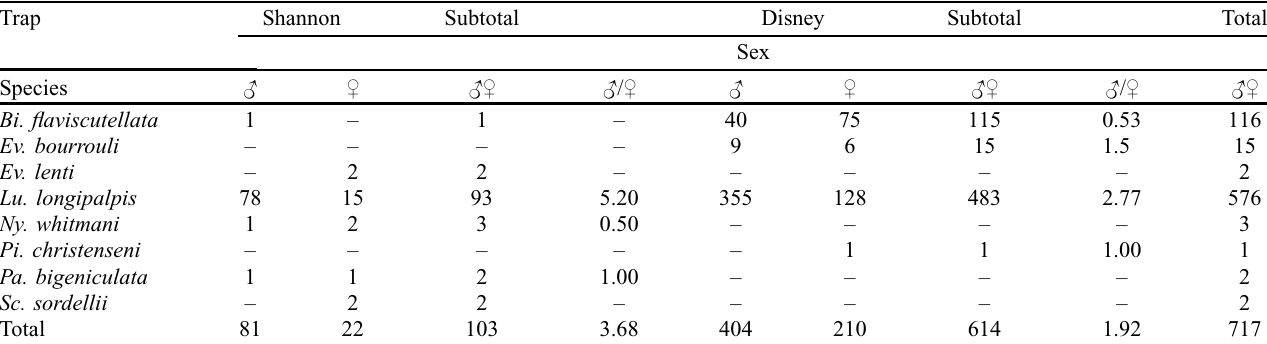
Table 1. Distribution of phlebotomines collected in the peridomiciles and forest fragment by sex and trap, Campo Grande, Mato Grosso do Sul, Midwest Brazil, 2007–2009.